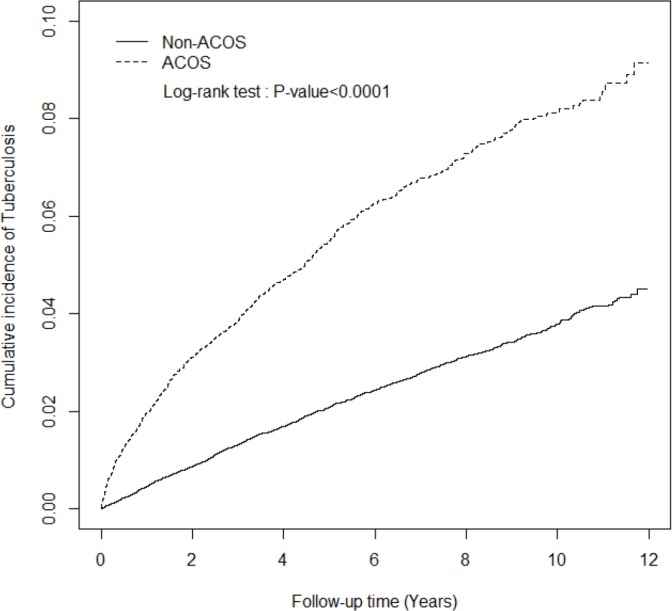
The cumulative incidence of tuberculosis in asthma–COPD overlap syndrome (ACOS) (dashed line) and non-ACOS cohorts (solid line).